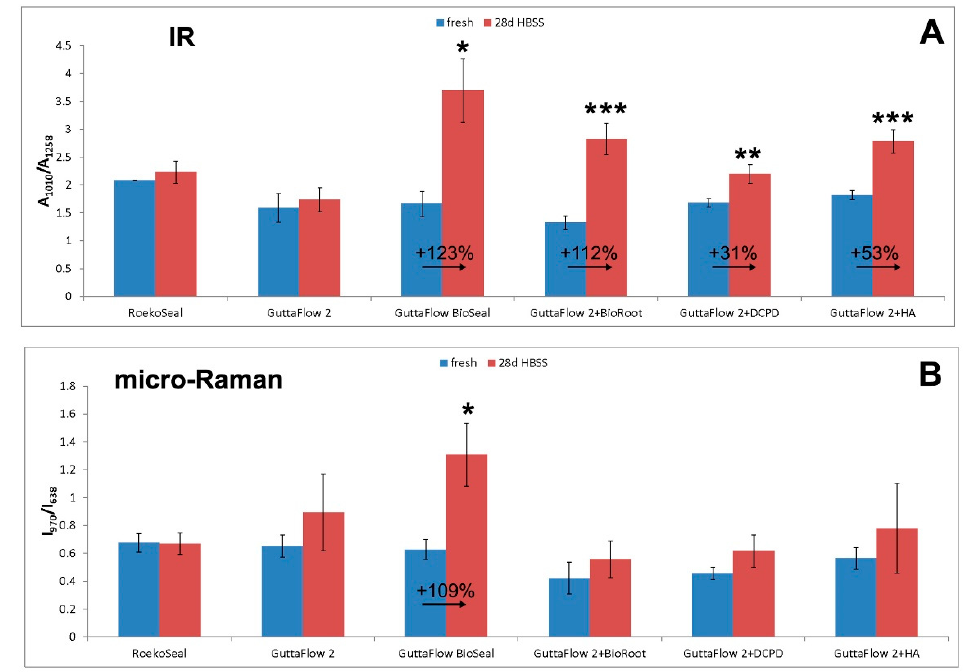
Figure 9. IR A 1010 /A 1258 ( A ) absorbance ratio, and Raman I 970 /I 638 ( B ) intensity ratio (average ± standard deviation) as calculated from the IR and micro-Raman spectra of the materials under study before (i.e., fresh samples) and after aging for 28 days in HBSS. Asterisks indicate significant differences (*: p < 0.01; **: p < 0.001; ***: p < 0.0001) between fresh and aged samples within the same material in a Tukey’s HSD test.